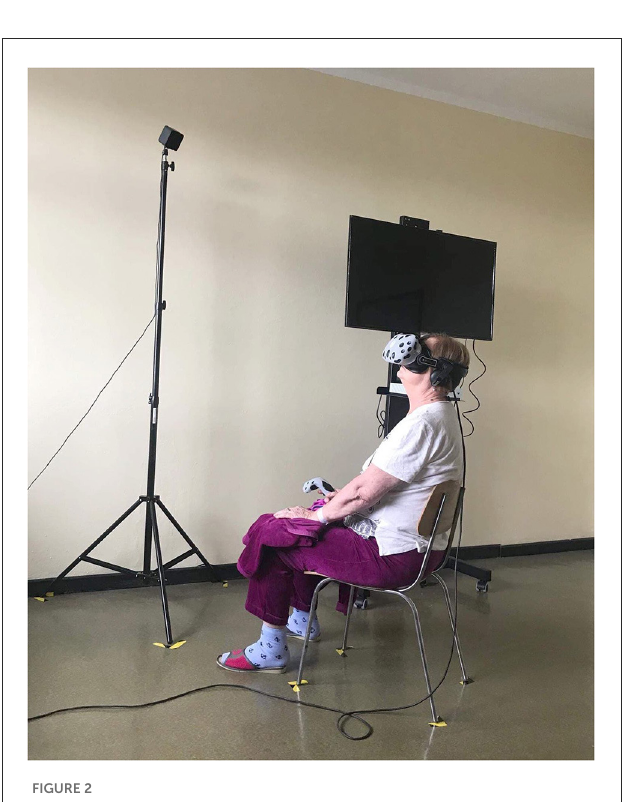
FIGURE2 VR station for